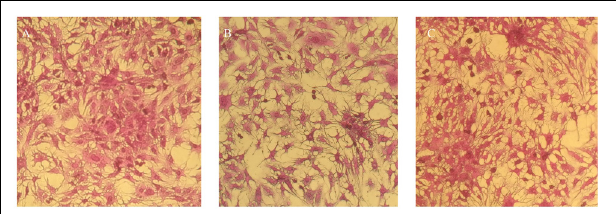
FIGURE 7 | Cytotoxicity analysis on HepG2 cancerous cell line (A) untreated HepG2 cells and (B) blank CSNPs (C) essential oil-loaded CSNPs. Cytotoxicity testing was done to check the safety of NPs on human cell. It can be observed that both the blank and EOs loaded chitosan NPs were not causing any cell damage.